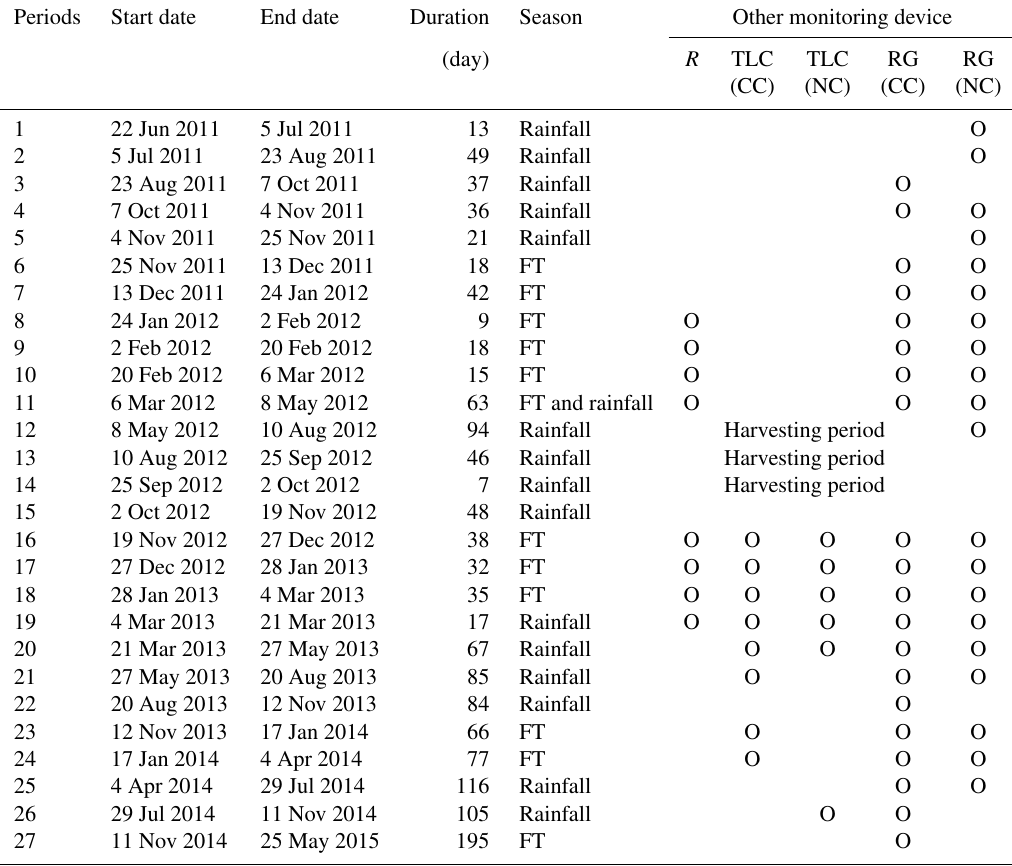
Table 2. Observation periods of sediment traps (periods 1 to 27) and operation periods of other monitoring devices. R , TLC, and RG indicate radiometers, time lapse cameras, and rain gauges, respectively. Monitoring of sediment traps in site CC was suspended during the harvesting period. Monitoring periods of ultrasonic sensors for snow depth, thermocouples, and extensometers were the same as that of